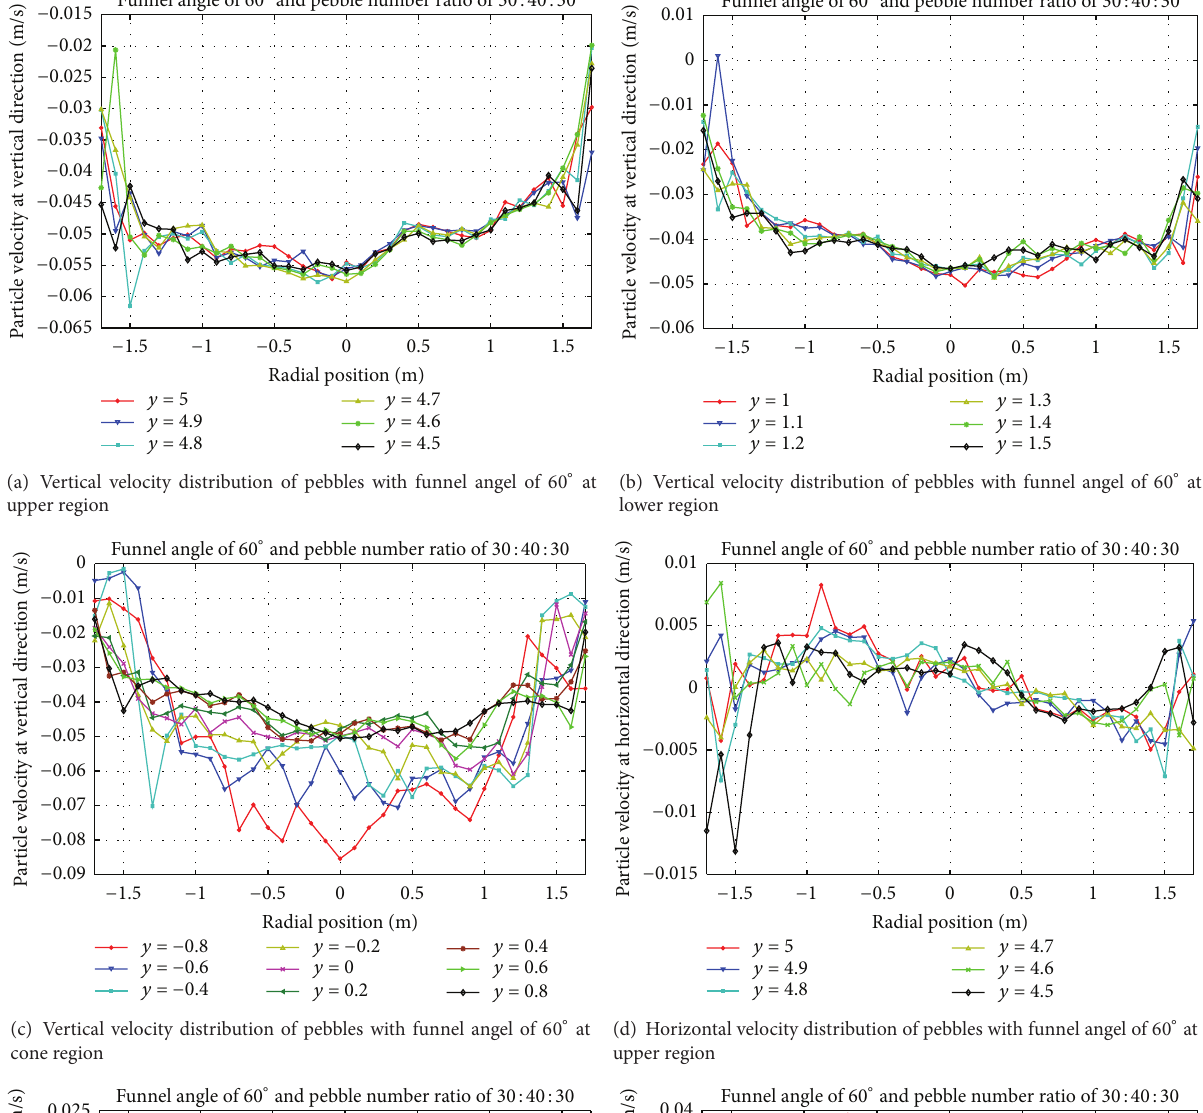
Funnel angle of 60 ∘ and pebble number ratio of 30 : 40 : 30